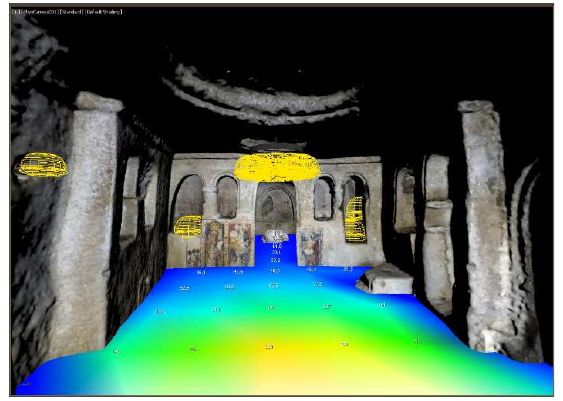
Figure 12: 3D Studio Max Sw. Lightmeter for lighting analysis. Natural and artificial light in the nave. h 08.00 a.m. - Date: 21 June 2018